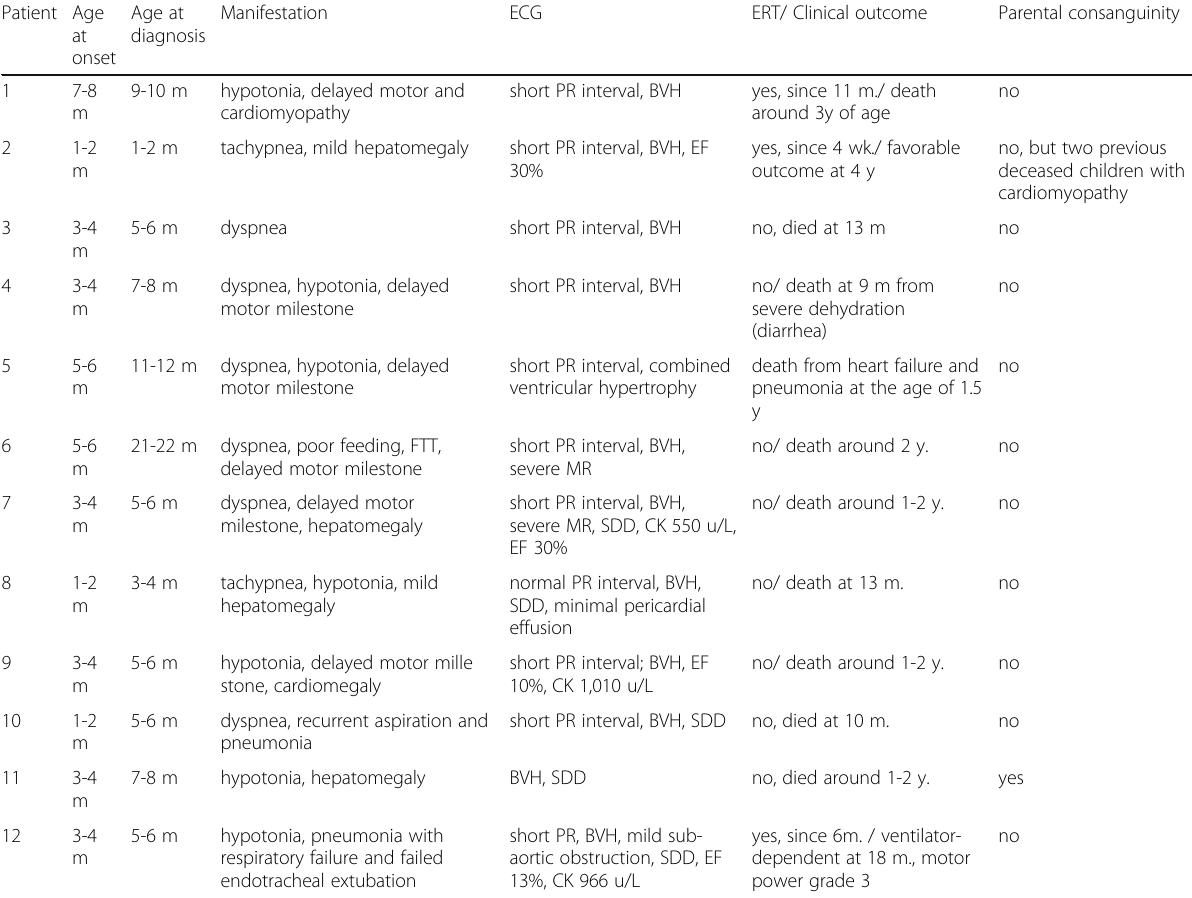
BVH Biventricular hypertrophy, CK Creatine kinase enzyme, ECG Electrocardiography, EF Ejection fraction, ERT Enzyme